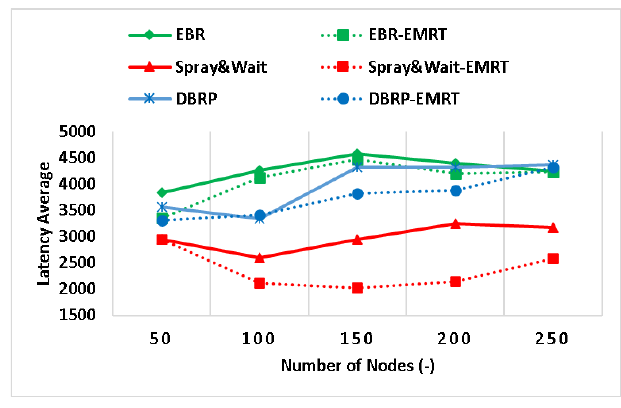
Figure 4. The latency average with different node densities.